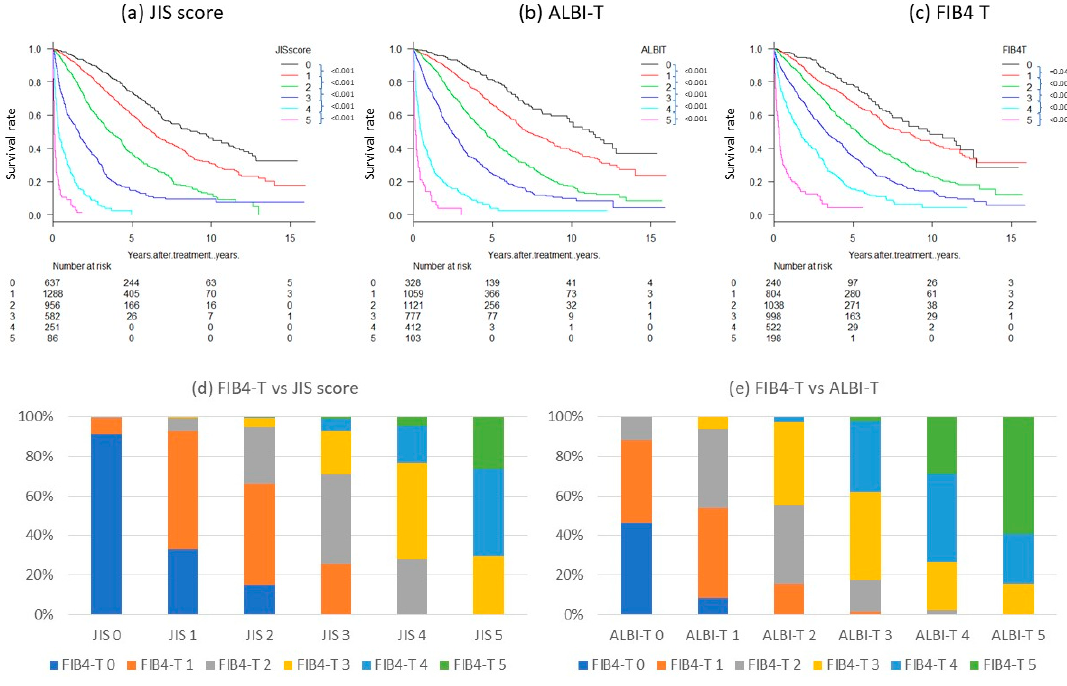
Figure 2. Overall survival rate according to ( a ) JIS score, ( b ) ALBI-T, and ( c ) FIB4-T (n = 3800) and Distribution of FIB4-T in ( d ) JIS score and ( e ) ALBI-T. The difference in survival between FIB4-T (0) and (1) was small compared with those in JIS score and ALBI-T, but prognosis of FIB4-T (0) was significantly better than prognosis of FIB4-T (1) ( p = 0.048). The p -value for each group was FIB 4-T 0–1: 0.048, 1–2: